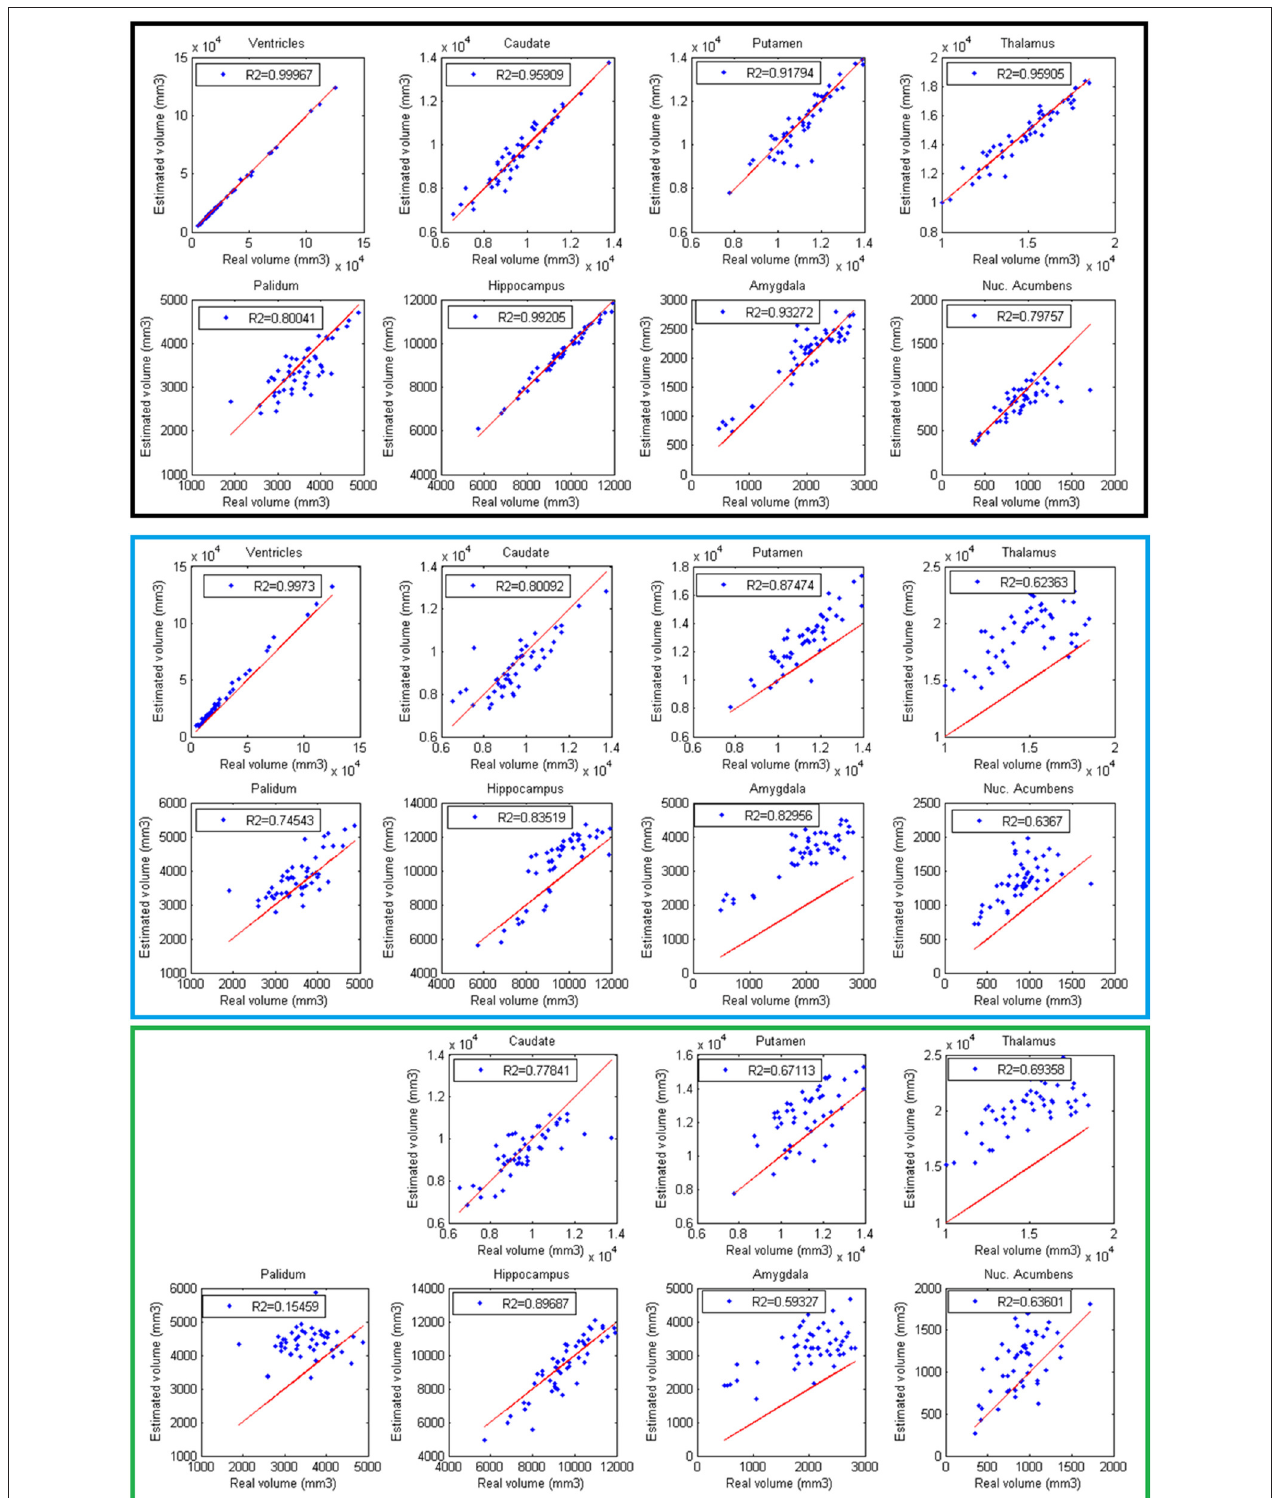
FIGURE 6 | Correlation between volumes obtained with volBrain (Black, first 2 rows), Freesurfer (Blue, 3 and 4 rows), and FIRST (Green, last 2 rows) and volumes obtained with manual segmentations considered as the gold standard. Red lines represent identity.